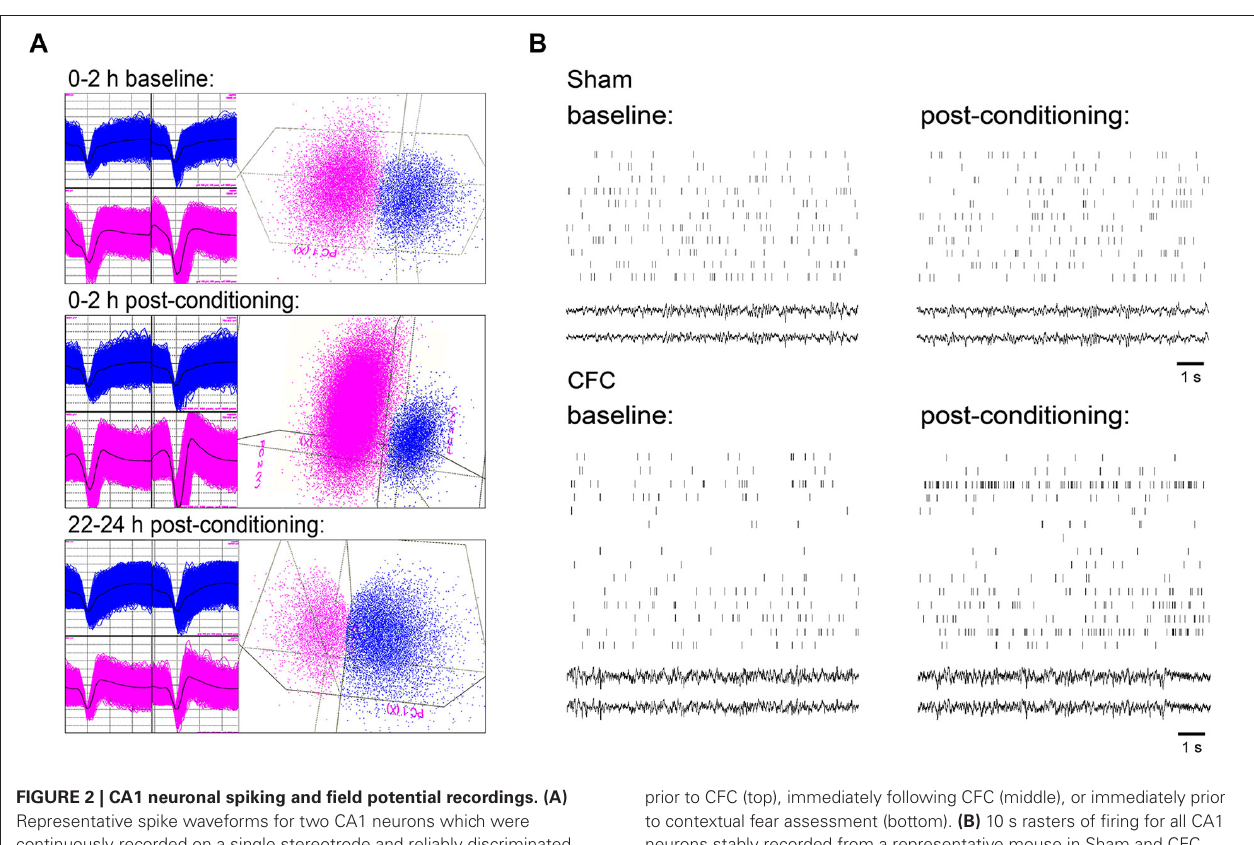
FIGURE 2 | CA1 neuronal spiking and field potential recordings. (A) Representative spike waveforms for two CA1 neurons which were continuously recorded on a single stereotrode and reliably discriminated across 24 h baseline and 24 h post-CFC periods (left), and mapping of spike waveform clusters in three-dimensional principal component space (right). Data shown comprise waveforms collected over 2 h windows, either 24 h